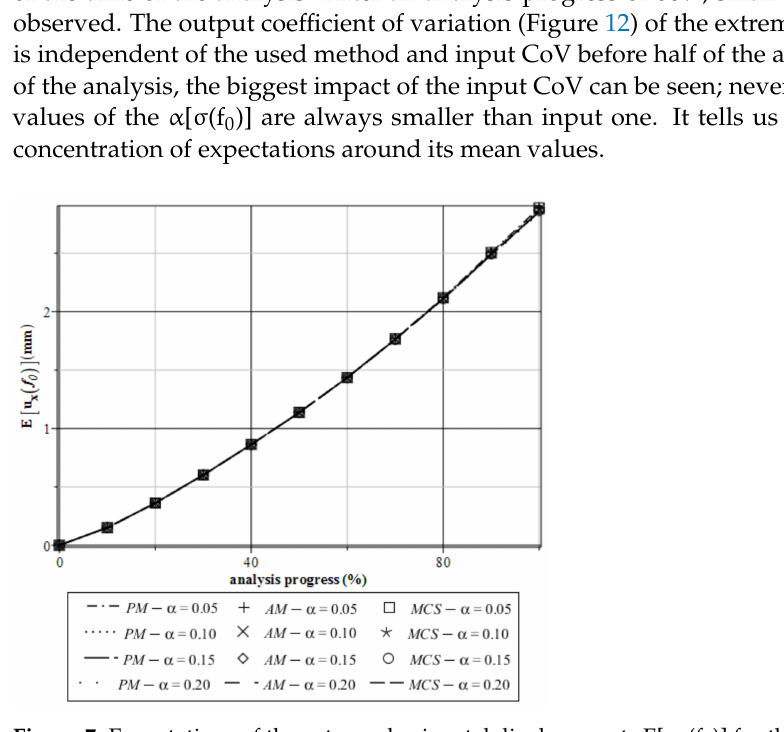
Figure 7. Expectations of the extreme horizontal displacements E[u x (f 0 )] for the